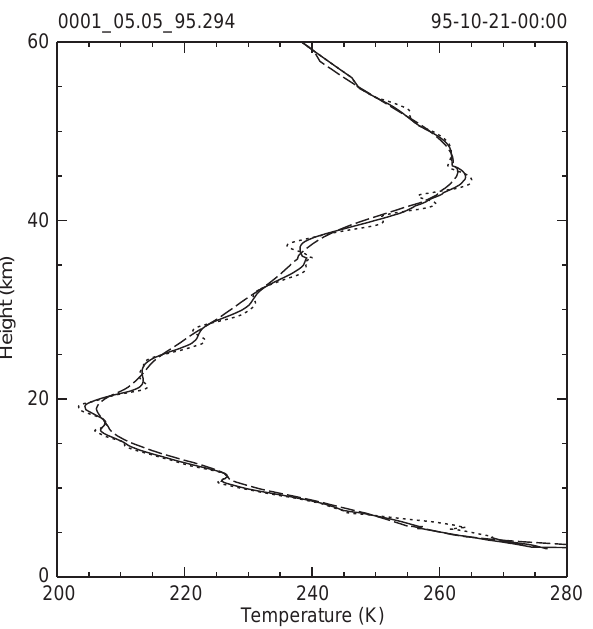
Fig. 6. Comparison of temperature profiles retrieved with Abelian matrix inversion ( solid line ), Abelian integral inversion calculated at the IMG/UoG ( dotted line ), and Abelian integral inversion calculated at UCAR, Boulder ( dashed line ). The GPS/MET data are from the occultation event 3 on October 21, 1995, 00:05 UT, located at 10.5 (cid:176) N and 136.7